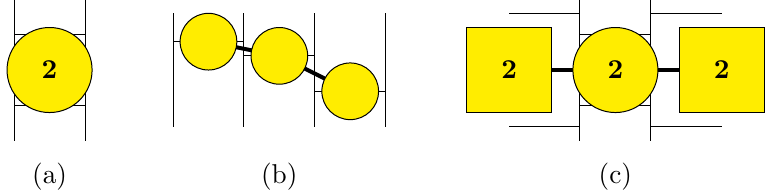
Figure 4 . Quiver structure in simpli(cid:12)ed webs: (a) SU(2) gauge theory, (b) A 3 quiver U(1) gauge theory, (c) SU(2) gauge theory with four (cid:13)avors. When the gauge group is U(1), we omit the number in the correspondong node for the gauge group